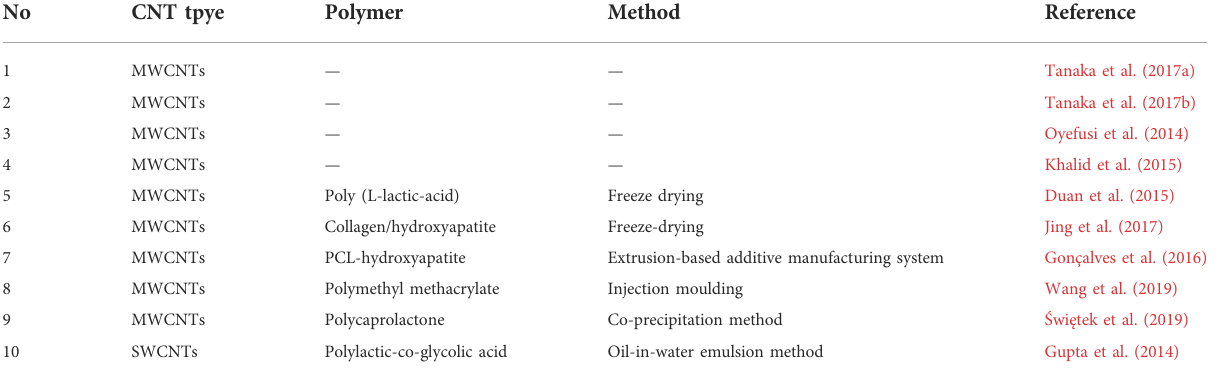
TABLE 3 A list of CNTs with polymers for bone tissue